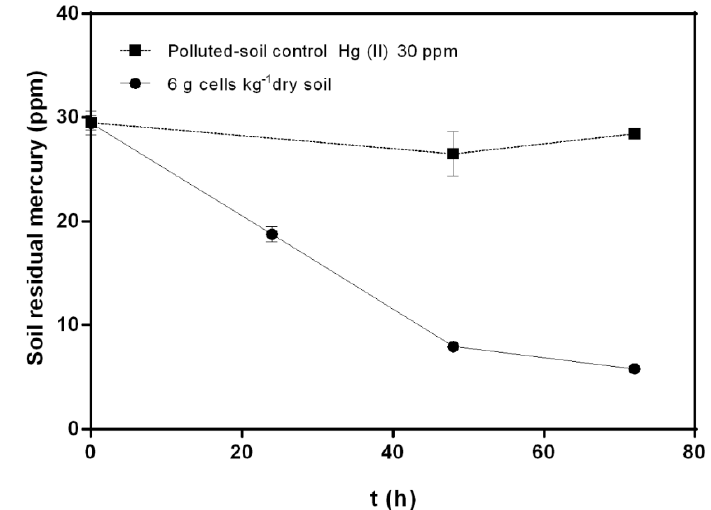
Figure 3. Effects of bioremediation by C. metallidurans MSR33 on agricultural soil polluted with mercury (II) (30 ppm) in rotary drum bioreactor. ( ■ ) Hg-polluted control soil, ( ● ) Hg-polluted soil bioremediation using 6 g cells kg − 1 dry soil MSR33 cells concentration. The assays were performed in duplicate. Bars indicate the standard deviation.